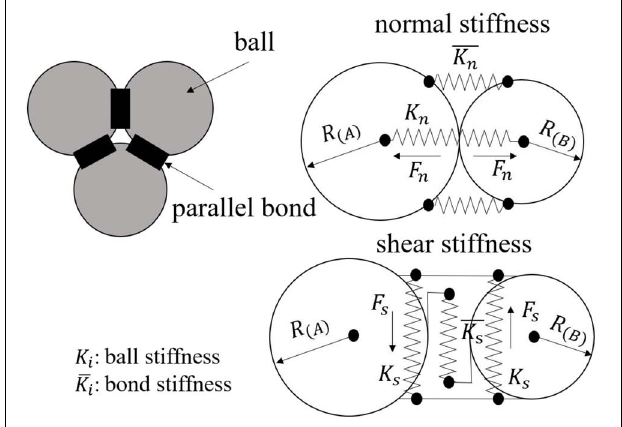
FIGURE 1 | Schematic representation of the BPM and the mechanisms of parallel